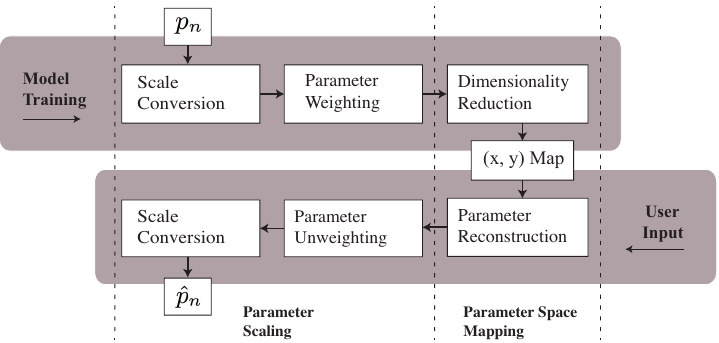
Figure 2. An overview of the proposed model. The grey horizontal paths represent training and implementation (user input)